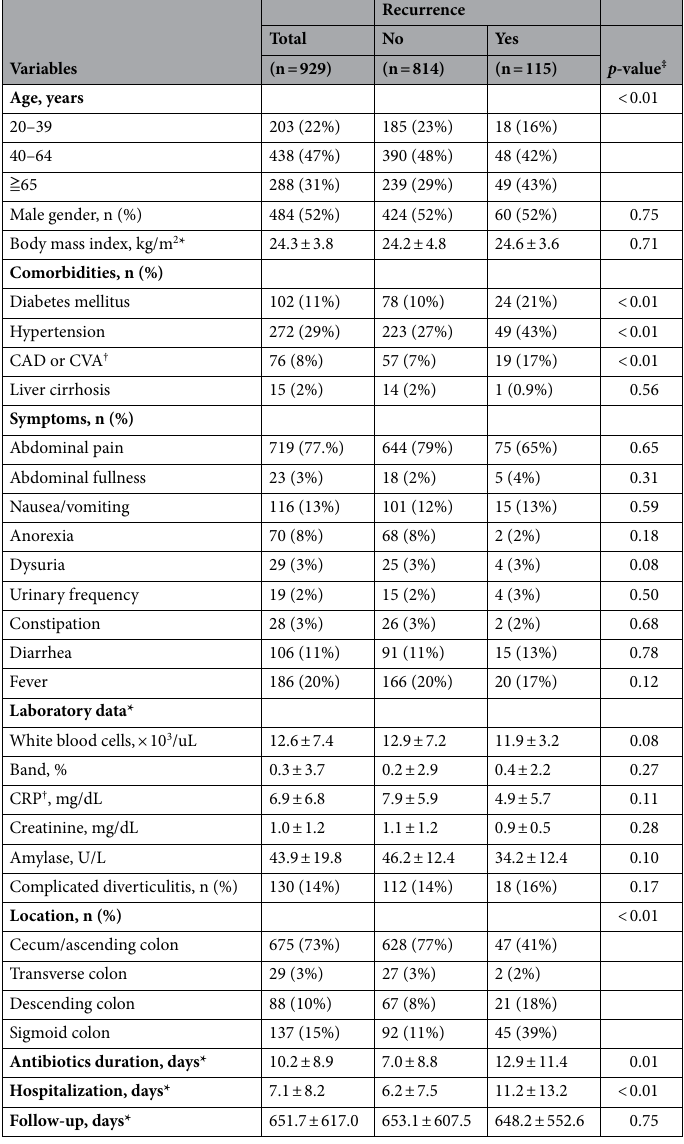
Table 1. Demographics of the included patients. *Presented with mean ± standard deviation. † CAD, coronary artery disease; CVA, cerebrovascular accident; CRP, C-reactive protein. ‡ Comparisons between the recurrence and the non-recurrence